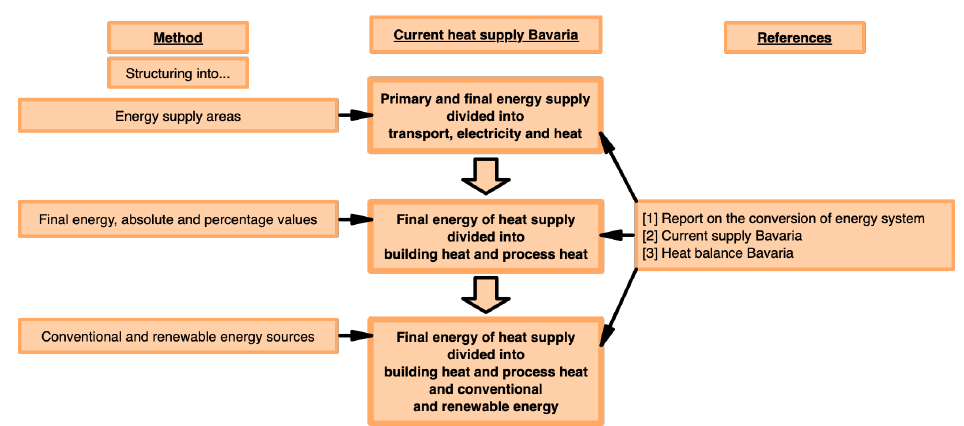
Figure 1. Balance heat supply residential buildings in Bavaria 2016.